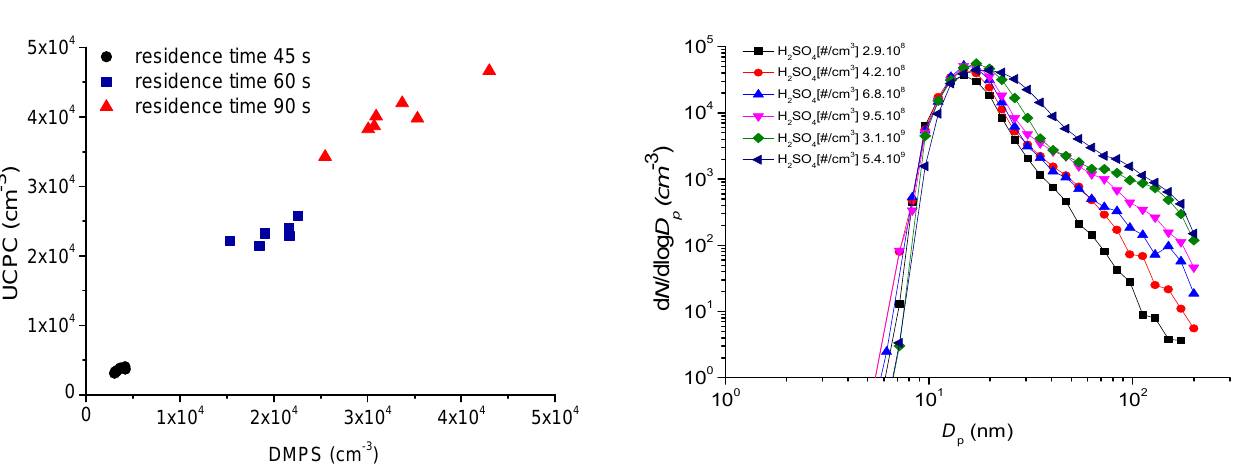
Figure 4. An almost linear relationship was reached by a compari- son of the particle number concentrations determined from a DMPS and a UCPC at different residence times, at T = 293K and with the RH set at 30%.